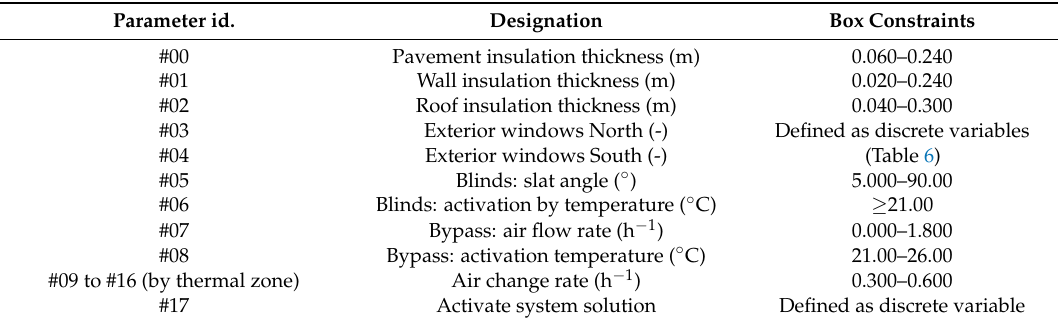
Table 5. List of parameters in action (continuous variables).